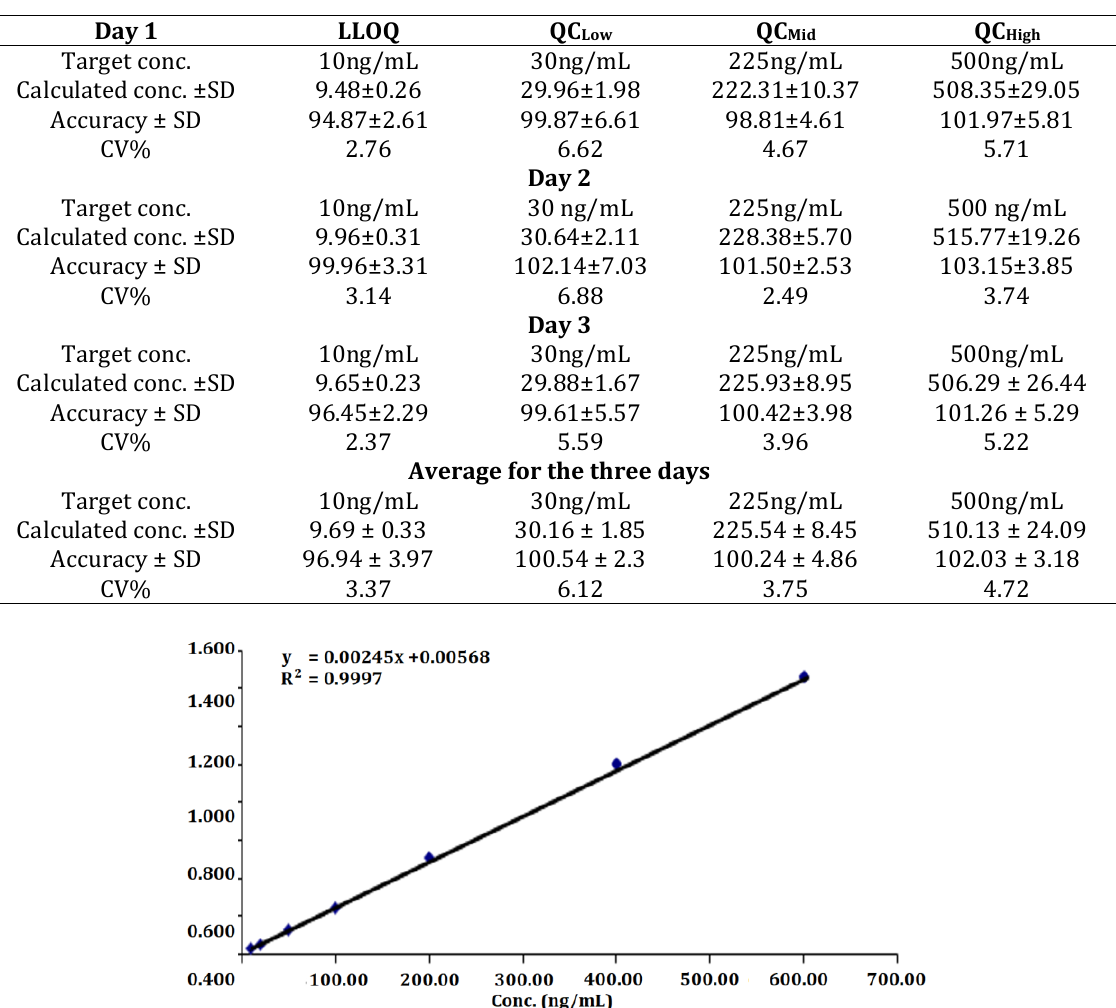
Table II. Results of inter and intra- day precision and accuracy. Day 1 LLOQ QC Low QC Mid QC High Target conc. Calculated conc. ±SD